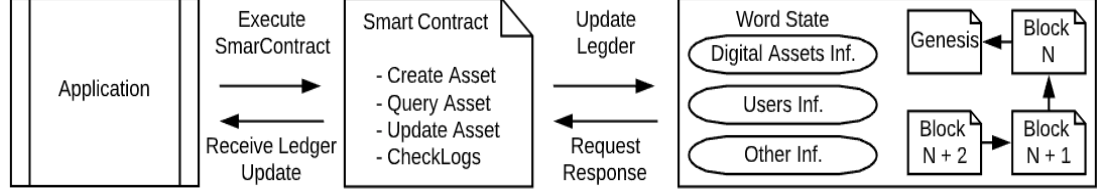
Figure 9. Operations in the ledger using smart contracts.